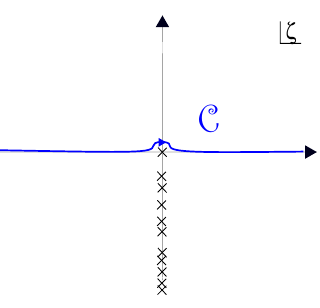
Figure 2 . The contour C used to define φ +